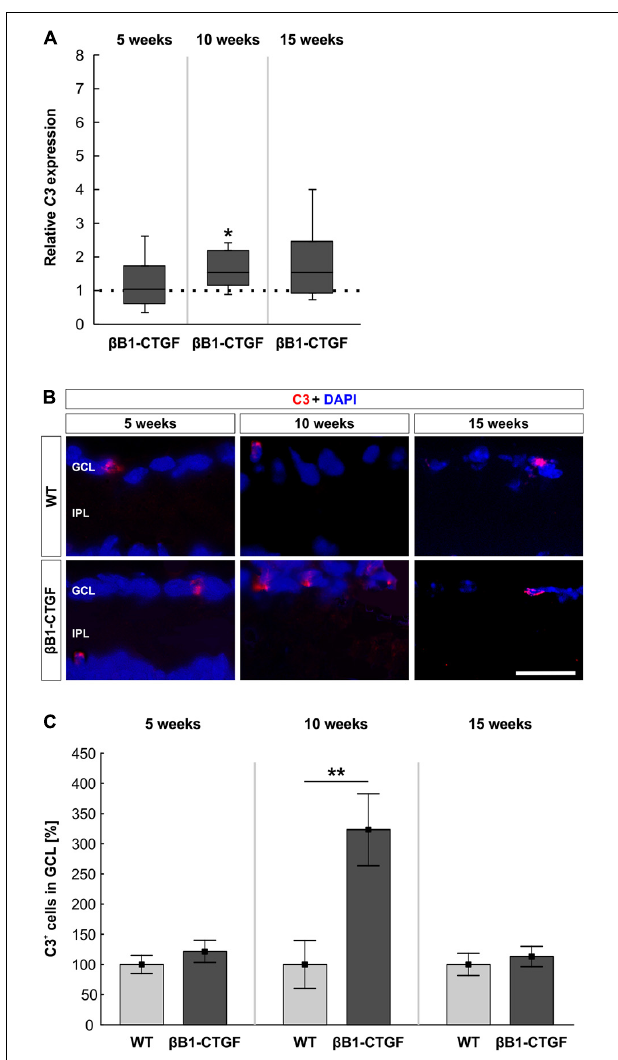
FIGURE 1 | Increased C3 expression in transgenic retinae. (A) C3 mRNA levels were increased in β B1-CTGF retinae at 10 ( p = 0.048), but not at 5 or 15 weeks. (B) Retinal cross-sections were stained with an antibody against C3 (red), while cell nuclei were labeled with DAPI (blue) at all ages. (C) The number of C3 + cells in the ganglion cell layer was not altered at 5 and 15 weeks. At 10 weeks, significantly more C3 + cells could be observed in retinae of β B1-CTGF mice compared to WT ( p = 0.009). Values for RT-qPCR are median ± quartile ± minimum/maximum ( n = 5–7/group). The dotted line in panel (A) represents the relative expression of the WT group. Values for immunohistology are mean ± SEM ( n = 7–9/group). GCL, ganglion cell layer; IPL, inner plexiform layer. Scale bar: 20 µ m. * p < 0.05, ** p <